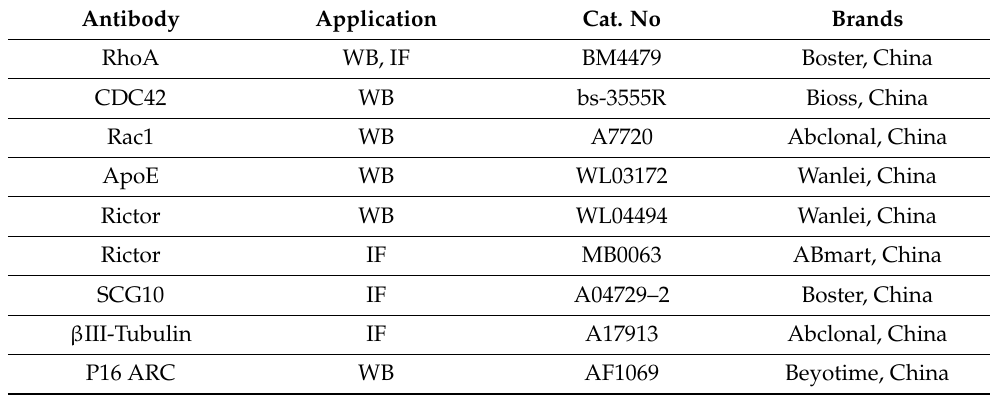
Table 1. Antibodies used in the